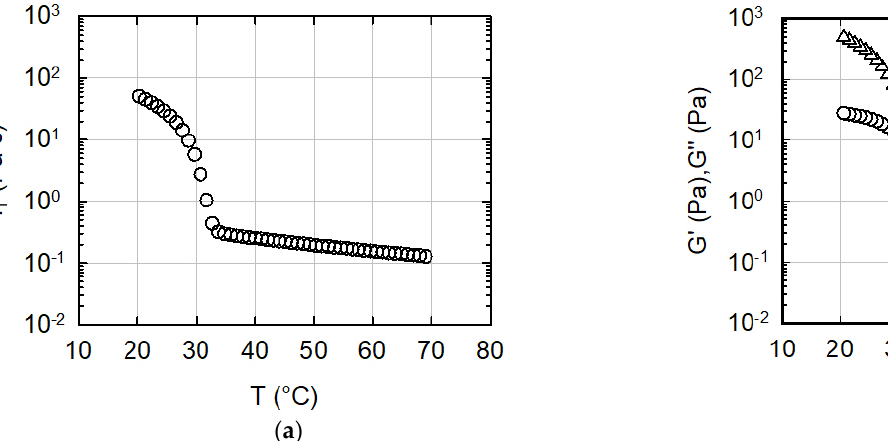
Figure 3. The linear viscoelastic response of the kC bio-ink to a cooling-down history from 70 to 10 °C at a rate of 1 °C/min; the frequency is 10 rad/s, and the strain is 0.5%: ( a ) complex viscosity; ( b ) elastic and loss moduli.